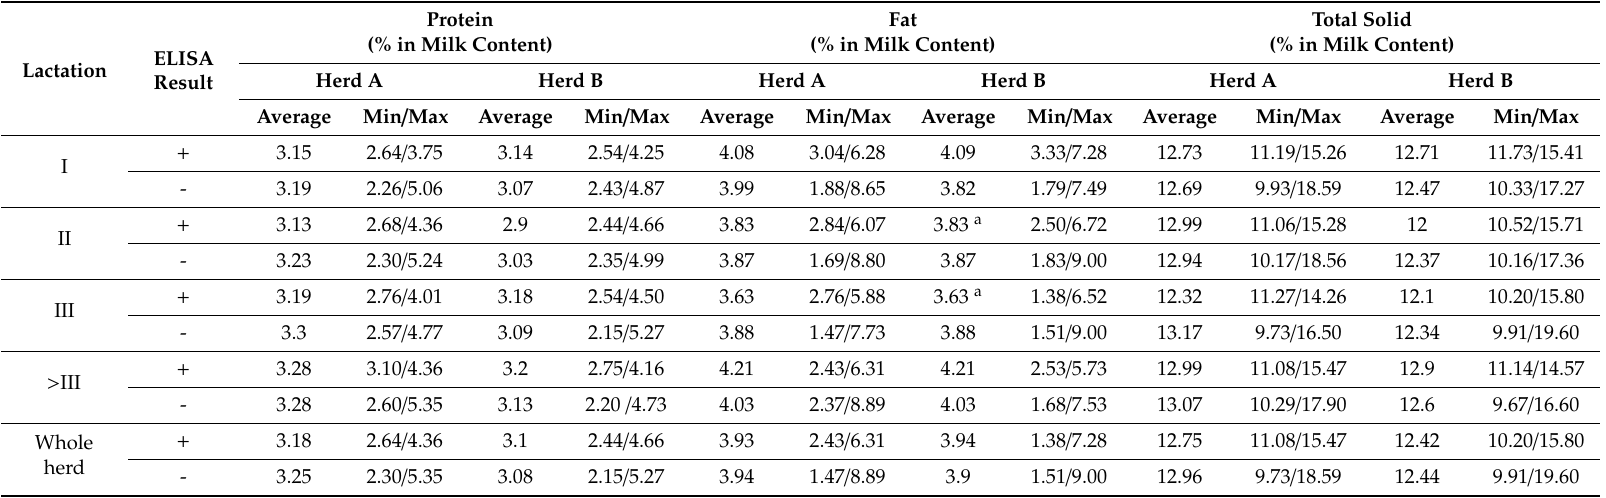
Table 3. A comparison of the percentages (%) of milk components in samples obtained from seropositive and seronegative animals in two tested herds (A and